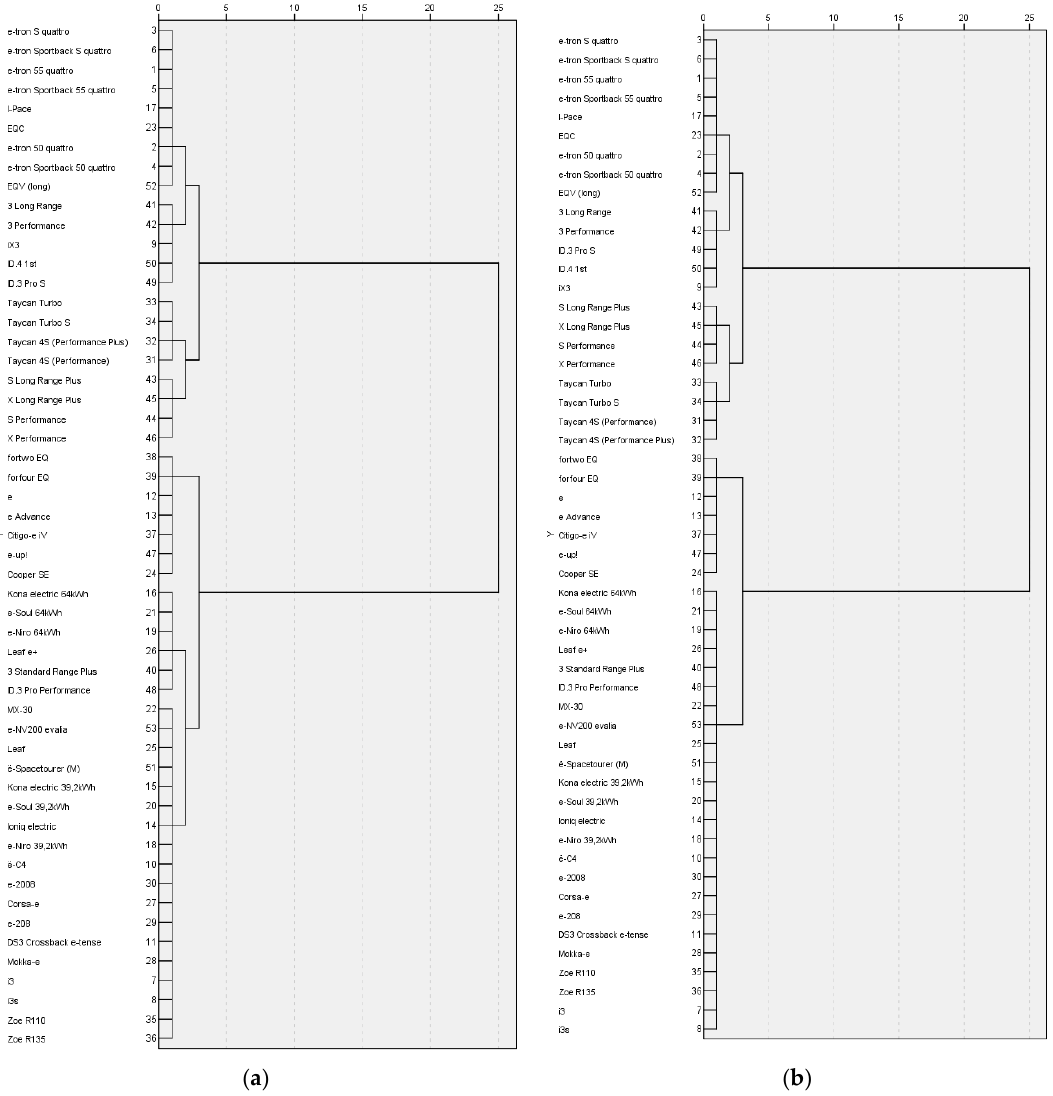
Figure 3. The process of merging into clusters: ( a ) excluding the “price” variable; ( b ) including the “price” variable. Based on Figures 2 and 3, the data set has been divided into 4 variants (subgroups). Table 8. List of cars assigned to particular The numbers of individual clusters are presented in Table 7. Table 7. Population of individual clusters.